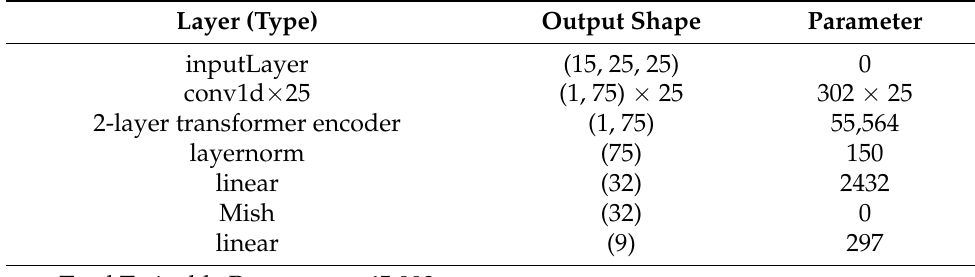
Table 7. Parameter summary of the proposed transformer model architecture over the University of Pavia data set.